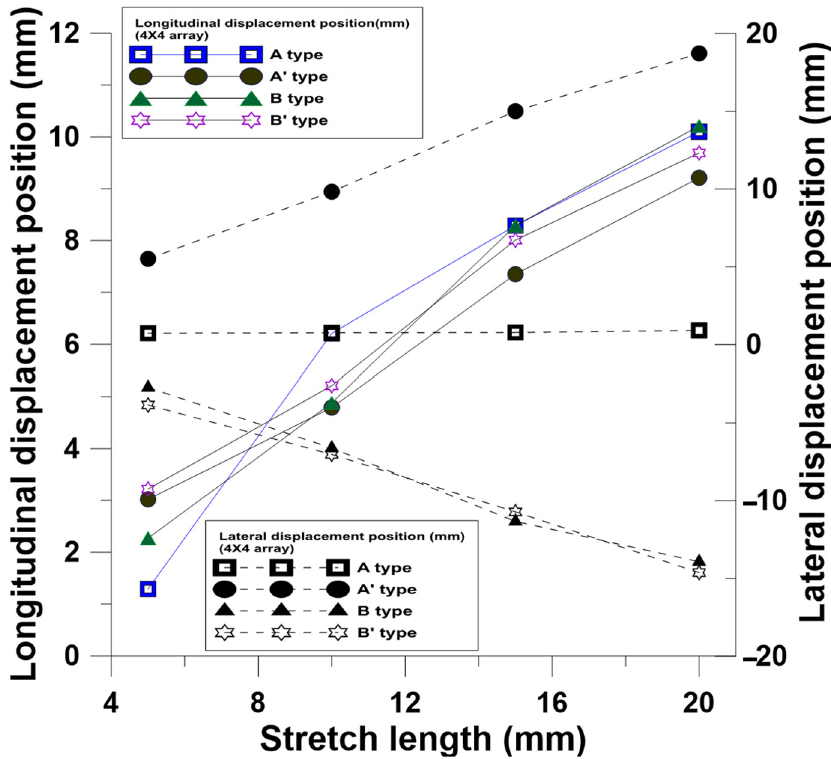
Figure 13. Relationship between changes in longitudinal displacement positions and lateral displacement positions of 4 × 4 NPR arrays at different stretching lengths. Table 1. Stretching test to test the elastic range of PDMS at three different ratios. Elastic Range (mm)